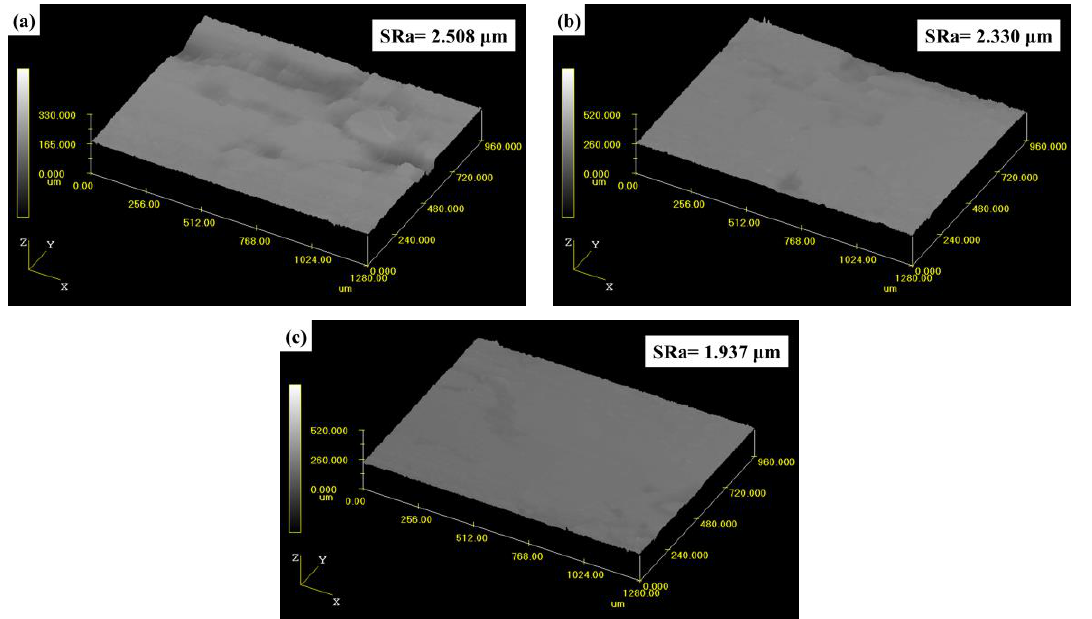
Figure 8. The three-dimensional profiles and surface roughness of the tested composite materials: ( a ) FMSF; ( b ) FMUF; ( c ) FMHF.